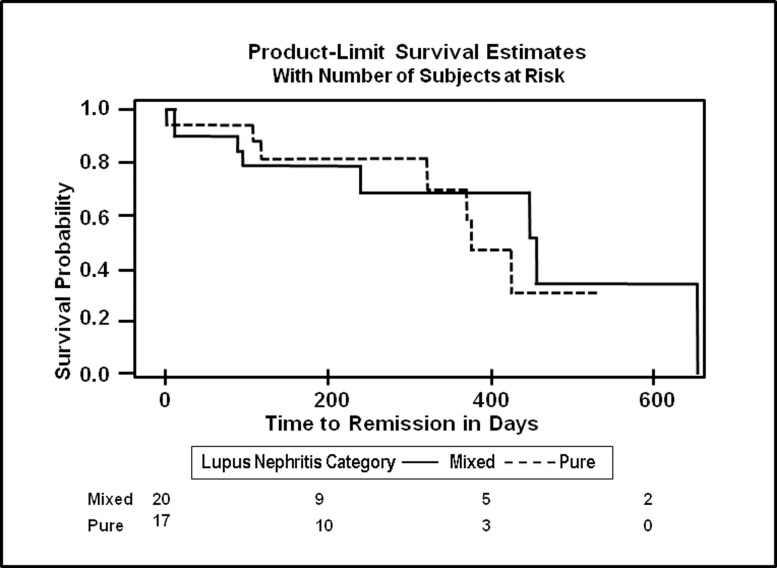
Kaplan Meier Plot of time to Complete Remission by Proliferative LN Category.Kaplan Meier plot showing the time to ESRD in days in individuals with MPLN and PPLN